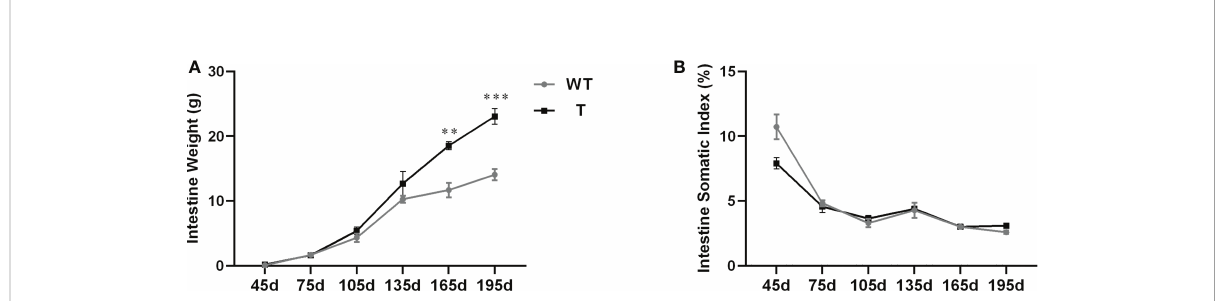
FIGURE 1 Intestinal development of transgenic (T) common carp ( Cyprinus carpio L.) that overexpress GH and wild-type (WT) common carp from age 45 to 195 days. (A) Intestine weight (n = 8). (B) Intestine somatic index (n = 8). ** P < 0.01, *** P <